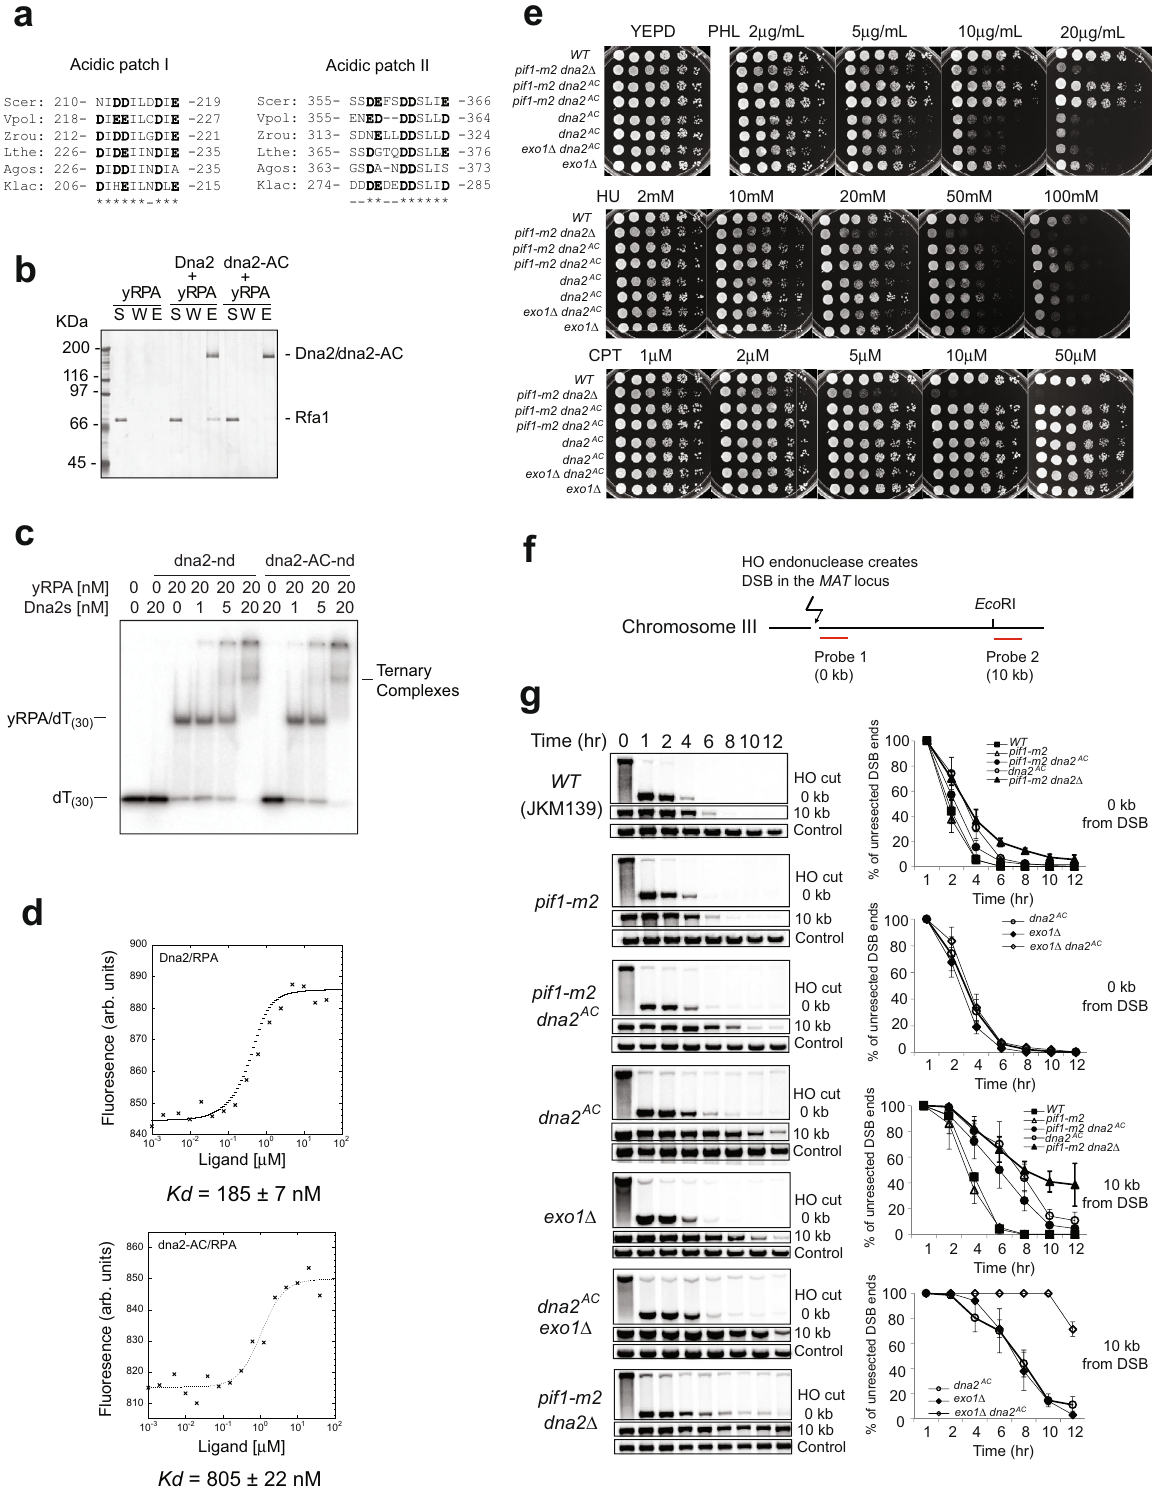
cross-linking mixture, which can react with the cross-linking reagent, BS 3 (bis[- RED-tris-NTA, and RPA was titrated as ligand to determine the Kd using hydrophilic capillaries at 30°C. The Kd values for MST assays were determined in Kd Fit mode in sulfosuccinimidyl] suberate, Thermo Fisher). To assess the interface between Dna2 NT Analysis software also from Nano Temper Technologies. and RPA in the presence of ssDNA substrate, Dna2 was incubated with RPA, with both present in solution at 1 μ M, at room temperature for 30min in the absence or the presence of dT (30) ssDNA (0.5 – 5 μ M), and in 25µL crosslinking buffer (20 mM Cross-linking assays . For cross-linking experiments, Dna2 and RPA proteins HEPES, pH 7.5, 150 mM NaCl, and 400 μ M BS 3 ). A separate group with 30 μ M dT replacing the dT (30) ssDNA was also set up. After incubation, the cross-linking were puri fi ed using a phosphate-based buffer system (pH 7.4), instead of the Tris- experiments were quenched by the addition of 2 μ L 1 M Tris-HCl, pH 8.0, and the HCl buffer system, to avoid non-protein sourced primary amine groups in the NATURE COMMUNICATIONS| (2022) 13:359